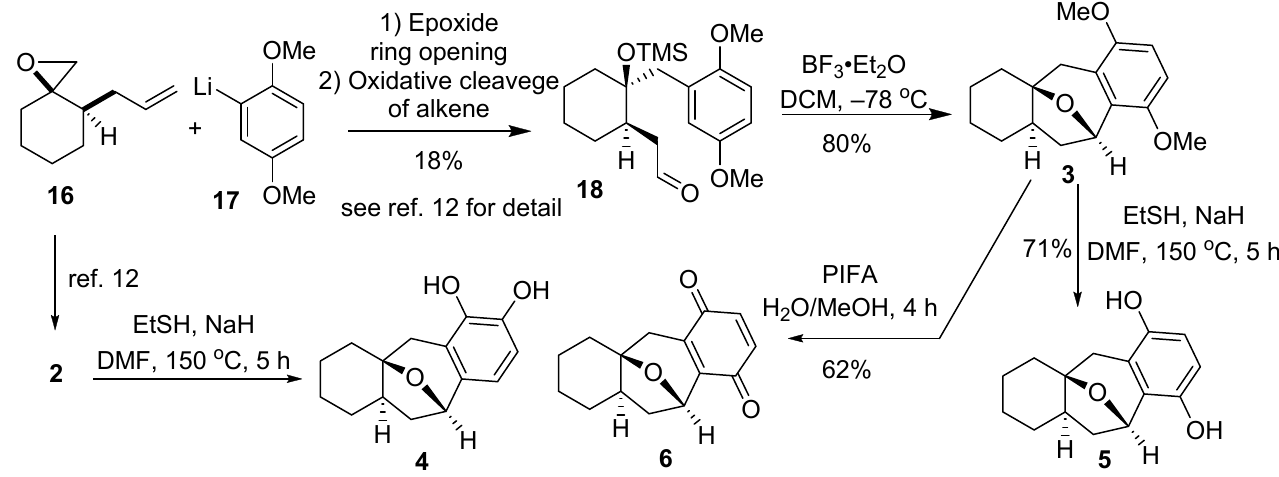
Figure 2. Design of brussonol analogs as new Plasmodium falciparum inhibitors.